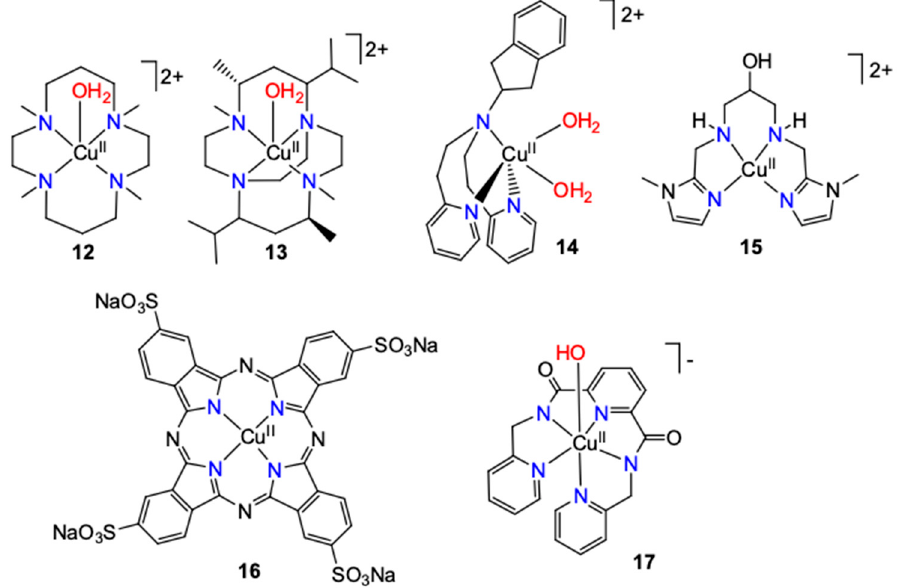
Figure 9. Schematic structure of various single-site catalysts.